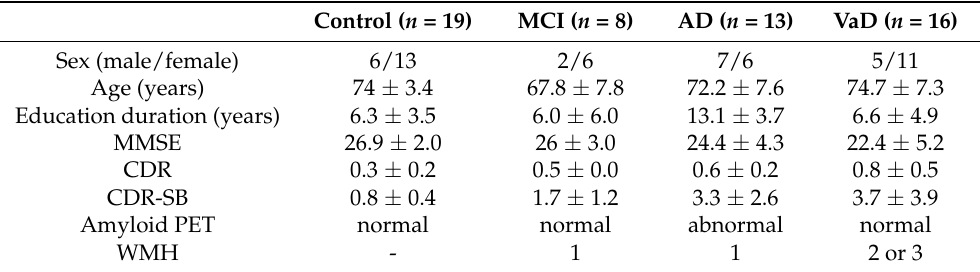
Table 1. Demographic and clinical characteristics of subjects.